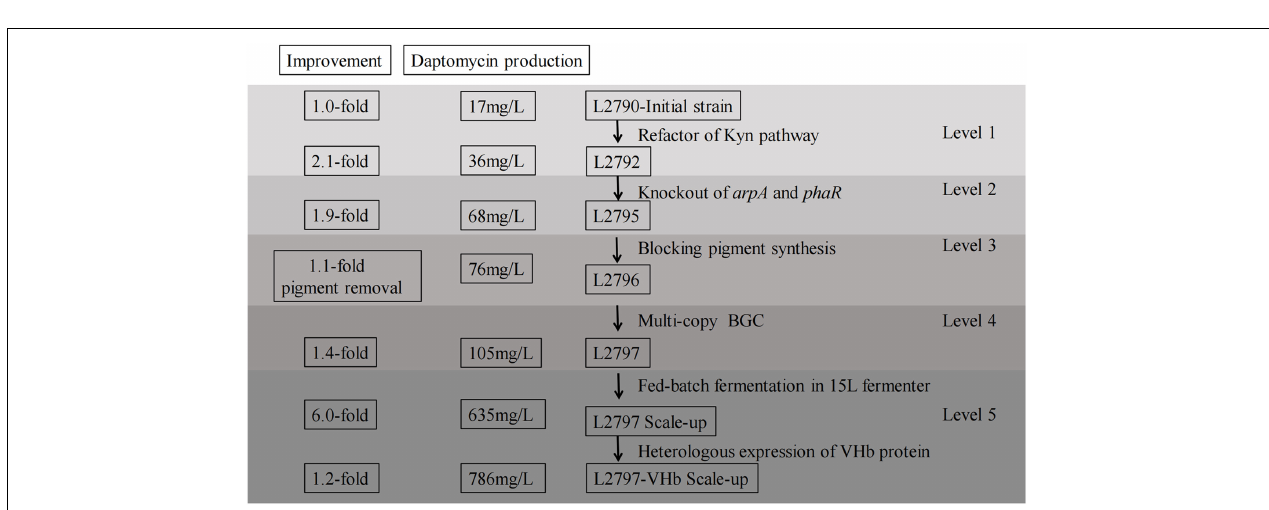
FIGURE 4 | Improving daptomycin production by fermentation process engineering. (A) Carbon monoxide (CO)-difference spectra analysis of L2797-VHb and L2797. (B) The daptomycin production curves of L2797-VHb and L2797 during the fermentation process in the 15-L fermenter. The fermentation samples were collected every 24 h from 96 to 264 h and the daptomycin production was analyzed by HPLC. The fermentation for each strain was performed in triplicate. Addition of precursor started from 96 h.